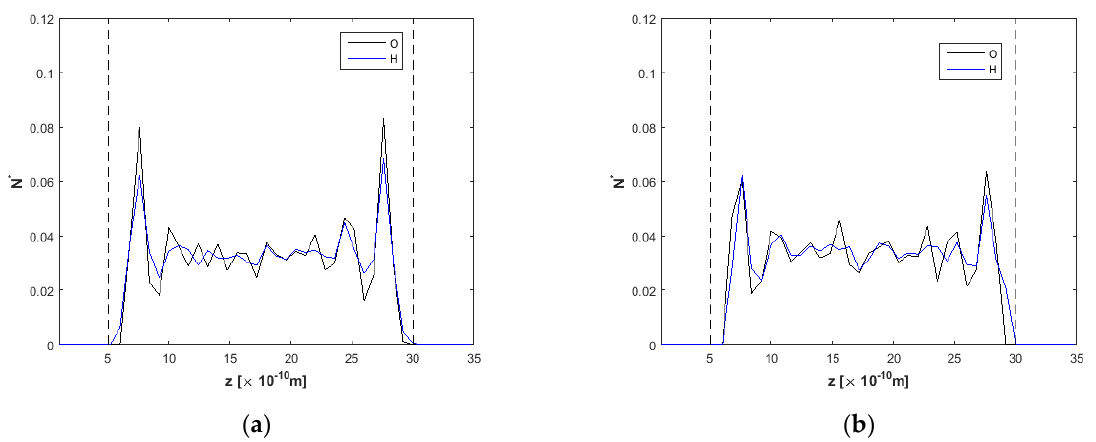
Figure 8. Density profiles for O and H, F ext = 0.025 kcal / molÅ and h = 2.5 nm, ( a ) at t = 5 ns, E = 0.0 V / Å Figure 8 . Density profiles for O and H, F ext = 0.025 kcal/molÅ and h = 2.5 nm, ( a ) at t = 5 ns, E = 0.0, V/Å and ( b ) at t = 20 ns, E = 2.0 V / Å. Dashed lines denote wall and ( b ) at t = 20 ns, E = 2.0 V/Å . Dashed lines denote wall limits.